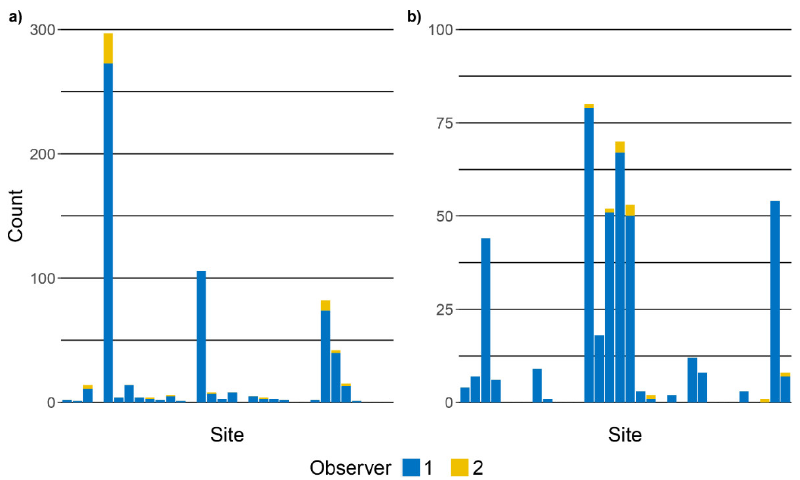
Figure 2. Counts of egg clutches at the 32 study sites for ( a ) Rana dalmatina and ( b ) Rana latastei . The blue bars indicate clutches detected by the first observer, and the yellow bars represent clutches not seen by the first observer and detected by the second observer.